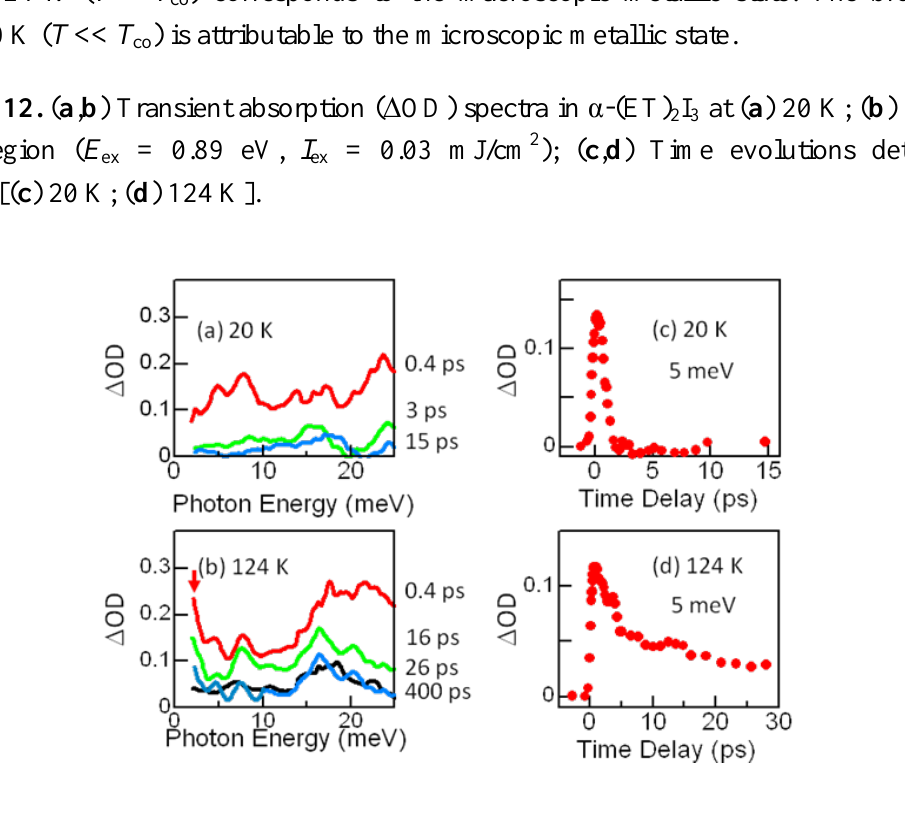
I at ( a ) 20 K; ( b ) 124 K in 2 3